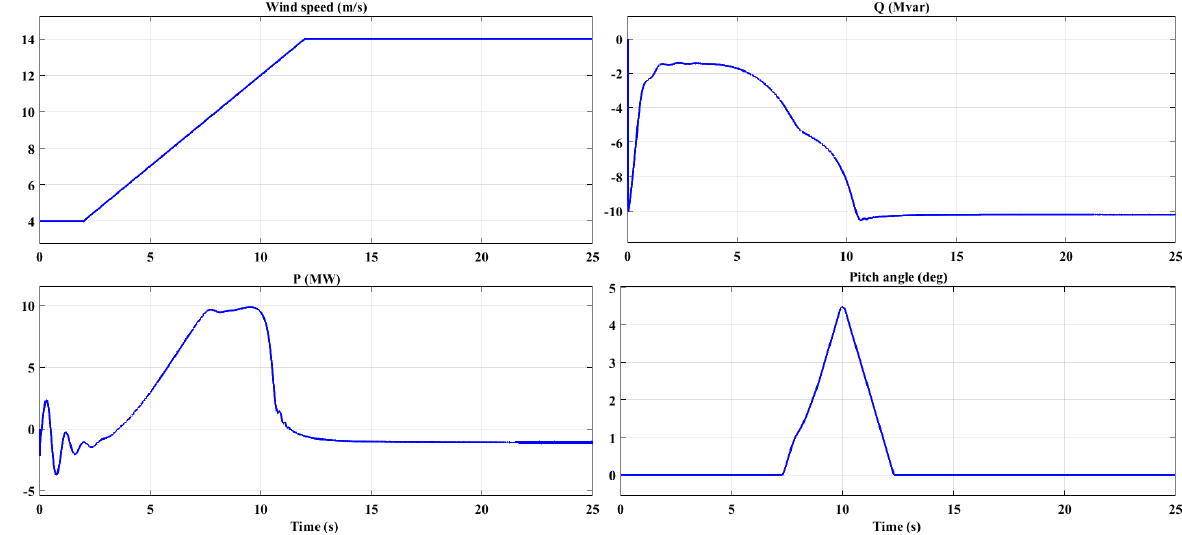
Figure 10. SCIG Wind turbine response at variable wind speeds.